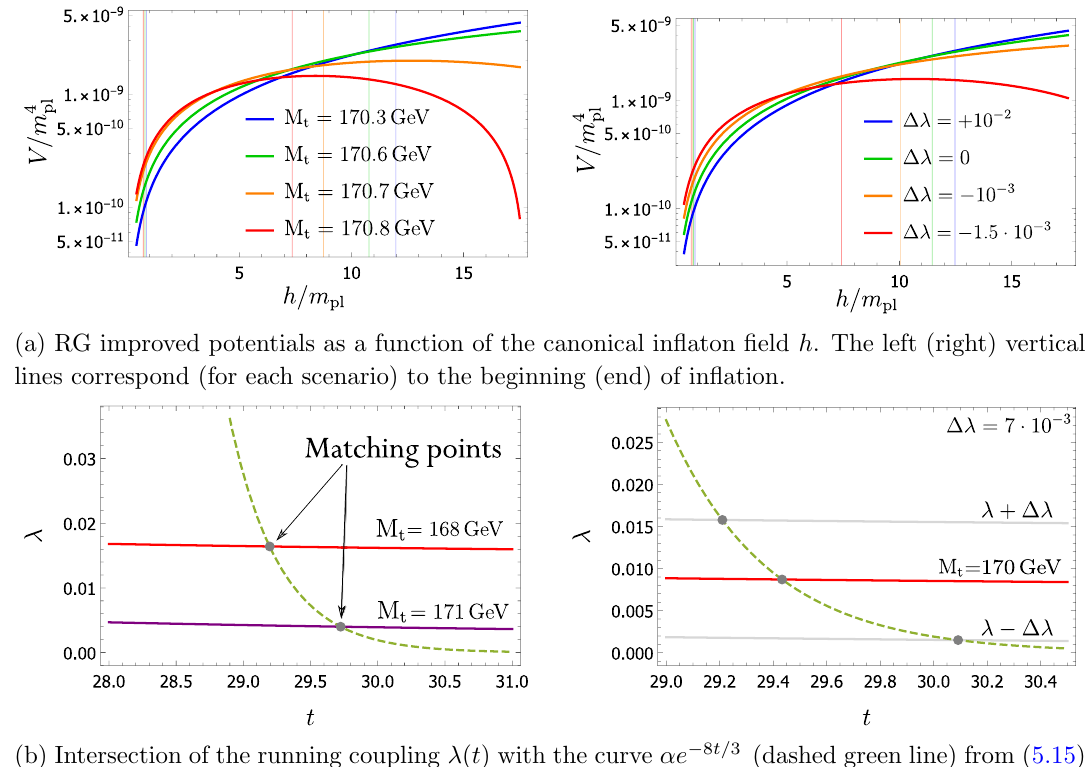
(b) Intersection of the running coupling (cid:21) ( t ) with the curve (cid:11)e (cid:0) 8 t= 3 (dashed green line) from (5.15) as a function of the renormalization time t . The intersection points give ( t eq ; (cid:21) eq ) and de(cid:12)ne the matching point. A larger top mass/negative threshold correction implies a smaller (cid:21) eq , and consequently larger corrections to the observables (see eq. (5.16)). Figure 2 . Case A: RG improved potential and matching point for M h = 125 : 6 GeV and di(cid:11)erent top mass (left) and ( M h ; M t ) = (125 : 6 ; 170) GeV and di(cid:11)erent threshold corrections